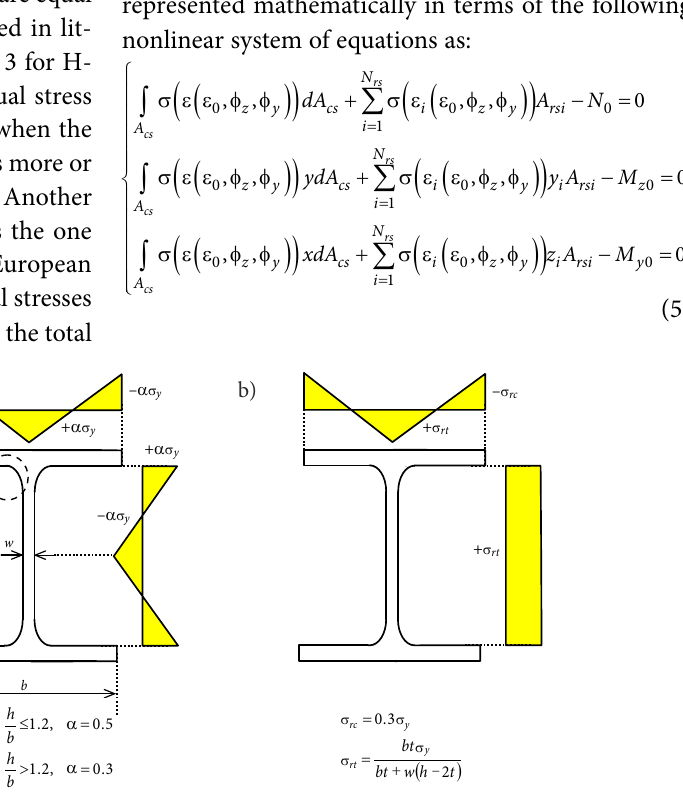
) patterns and fillet regions of steel r